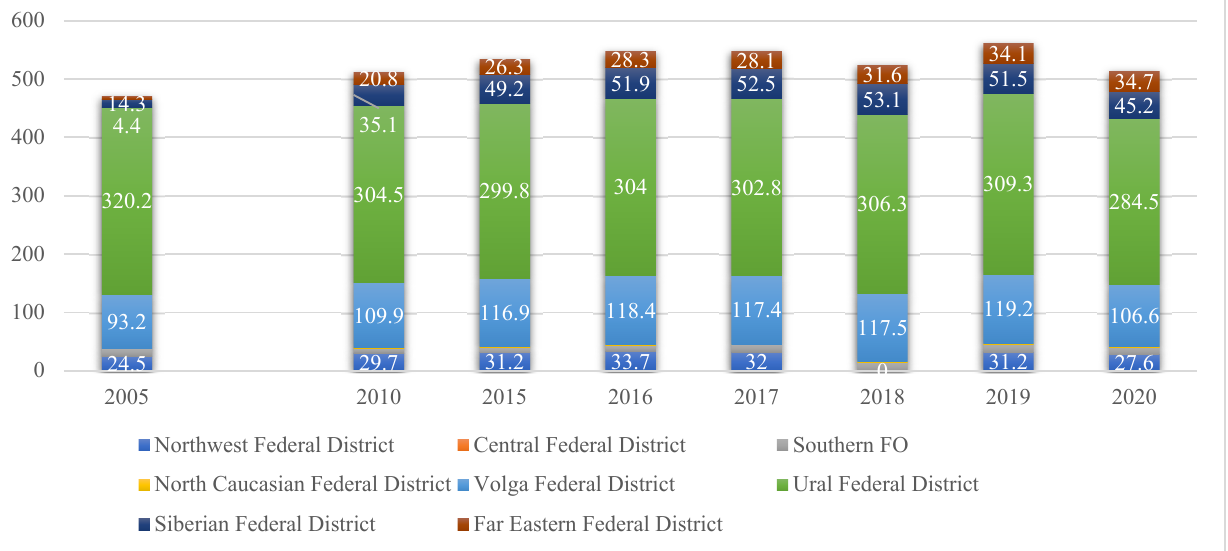
Figure 4. Dynamics of oil production by federal districts of the Russian Federation for 2005–2020, million tons. Compiled by the authors according to: Regions of Russia. Socio-economic indicators. 2021. 612–613. [Electronic resource]. Access mode: https://rosstat.gov.ru/storage/mediabank/RegionPokaz_2021.pdf; Oil production by the subjects of the Russian Federation (thousand tons) Electronic resource]. Access mode: